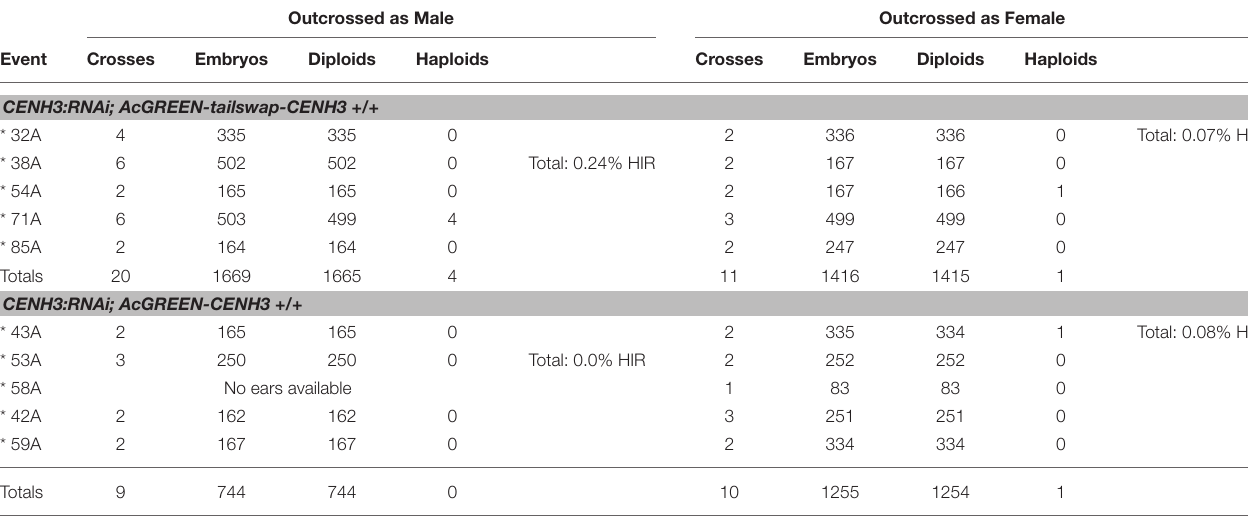
TABLE 2 | Haploid induction frequency determination for CENH3 RNAi lines complemented by AcGREEN-tailswap-CENH3 (top) and AcGREEN-CENH3 (bottom) transgenes. Outcrossed as Male Outcrossed as Female Embryos Diploids Haploids Crosses Embryos Diploids Haploids